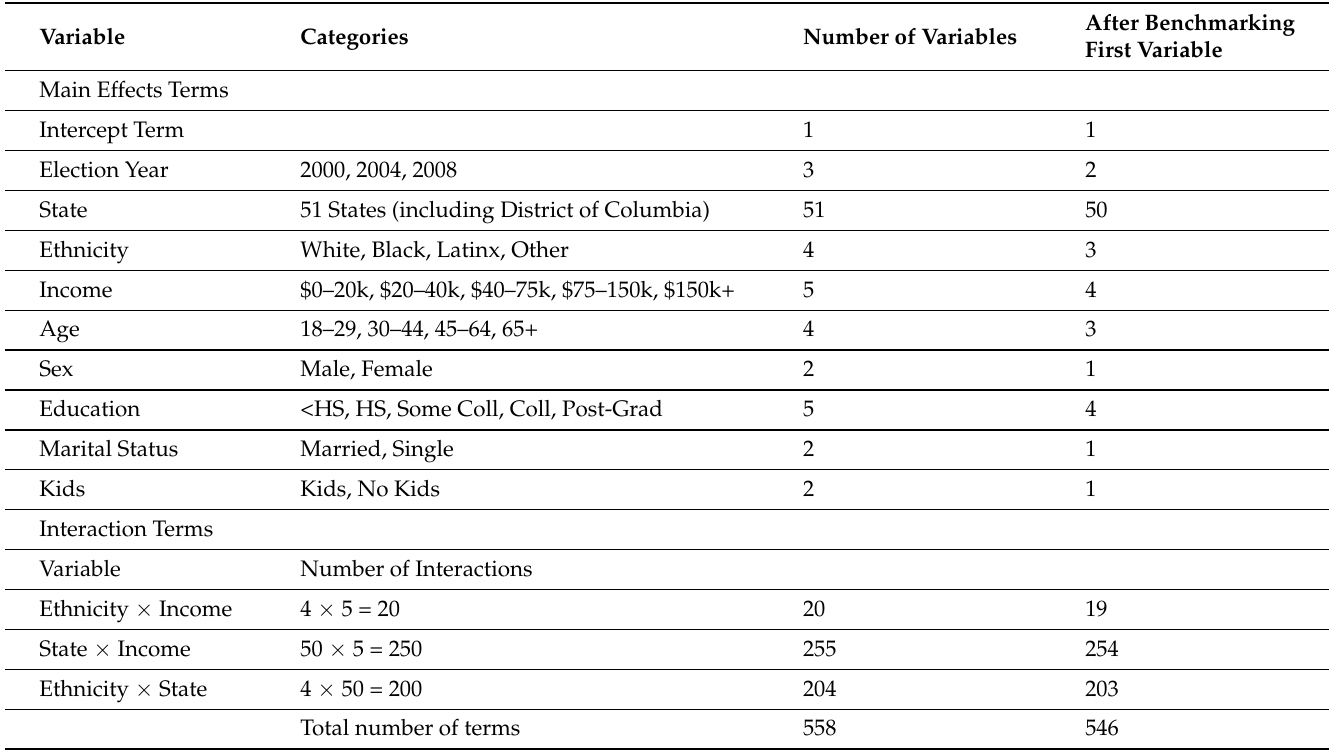
Table 2. Variables in Regression